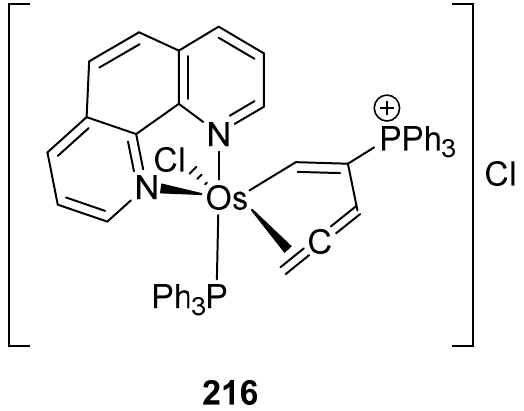
Figure 55. η 2 -Allene complex with promising cytotoxic activity.